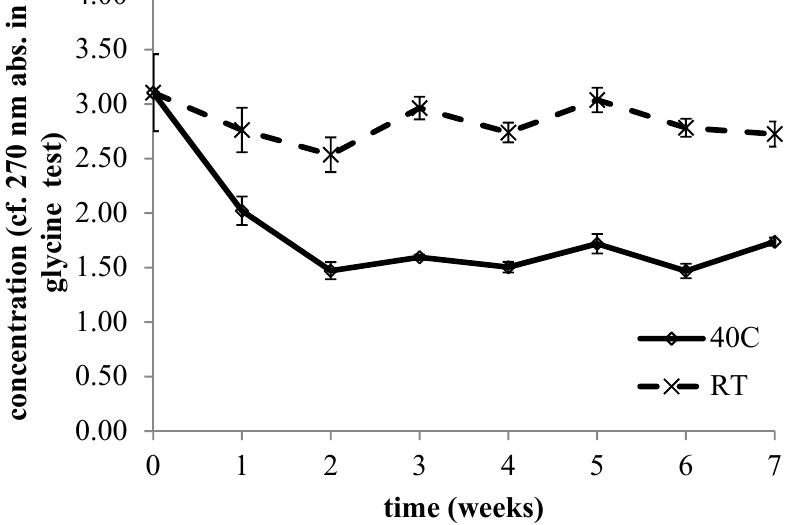
Figure 3. Time evolution for 8 weeks of GA concentration at 40 ° C and at room temperature, as measured by titration with glycine.